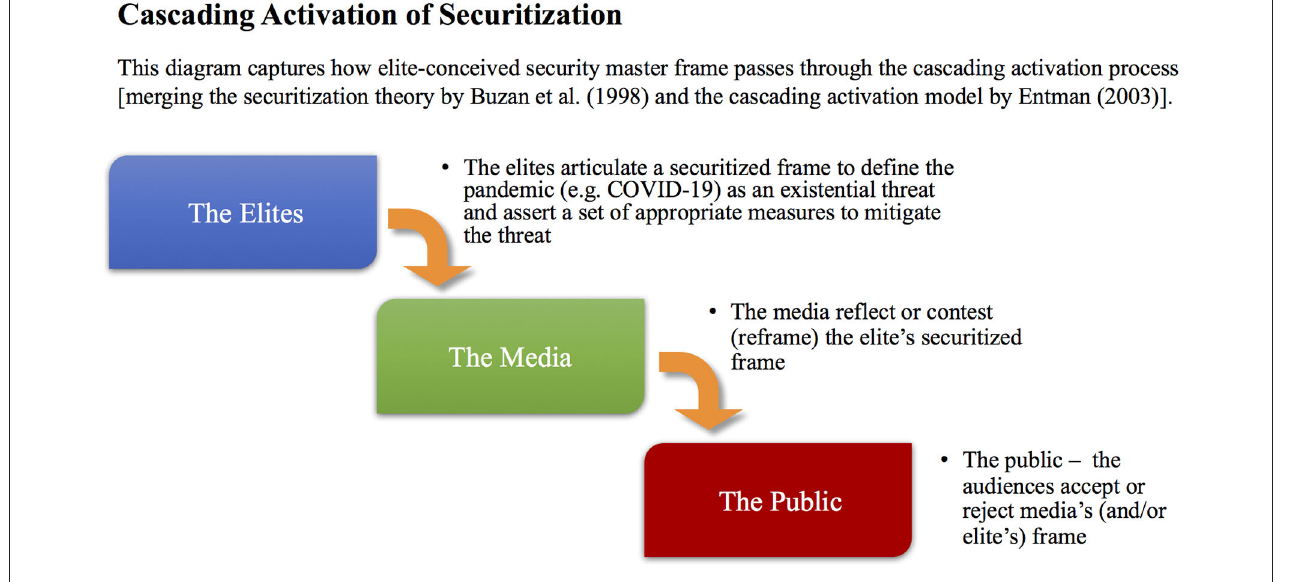
FIGURE 1 | Cascading activation of securitization. Elite-conceived security master frame passes through the cascading activation process [based on works of Buzan et al. (1998) and Entman (2003)].